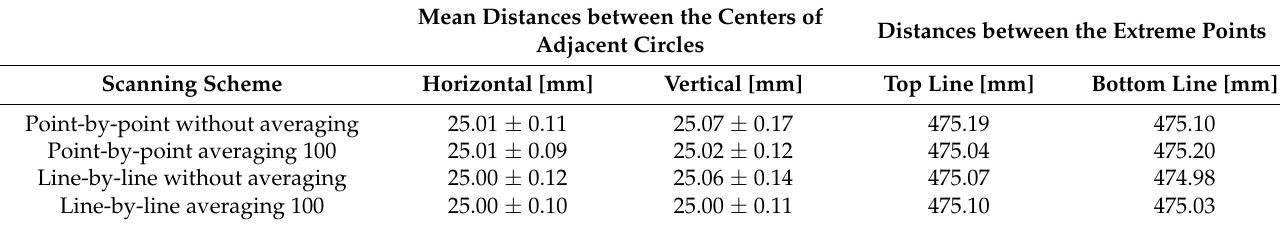
Figure 8. C-scan of the 6 mm hole during processing: raw ( a ), binarization ( b ), filtration ( c ), finding real values (25 mm and 475 mm). the circle with circular Hough transform ( d ), and the circle marked on the original image ( e ). Table 2. Horizontal and vertical means for different scanning schemes. In the next step, the distances between the centers of adjacent circles were calculated and averaged independently for the horizontal and vertical axes (Figure 7b–e). Finally, we Mean Distances between the Centers points (Table 2). Values obtained for all schemes are very similar and agree well with the real values (25 mm and 475 mm).